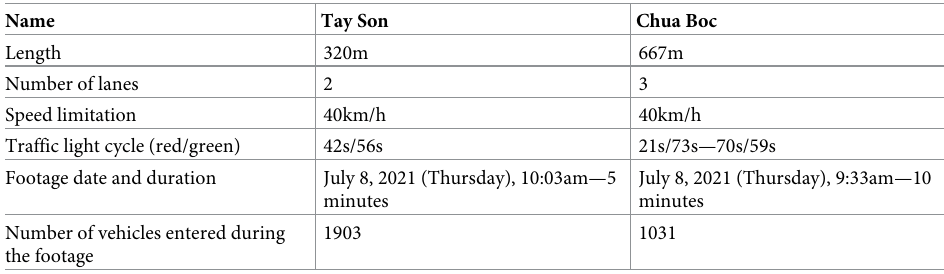
Table 10. Characteristic of the 2